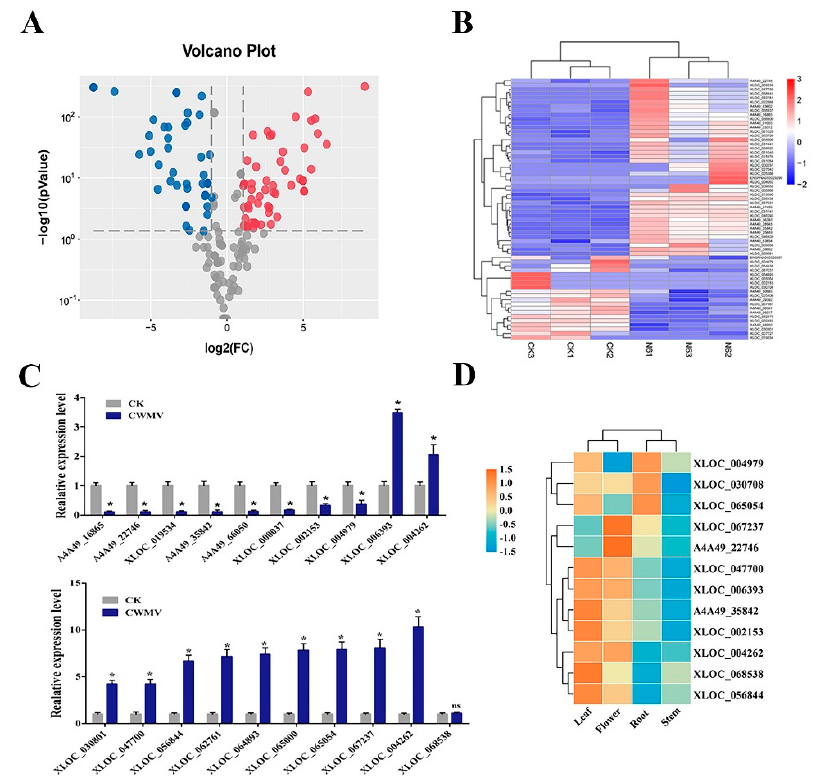
Figure 3. Identified differentially expressed lncRNA responses to Chinese wheat mosaic virus in Nicotiana benthamiana and verification of the expression level of differentially expressed lncRNAs (DElncRNAs) in different tissues by qRT ‐ PCR. ( A ) Volcano plots were created to distinguish DElncRNAs, Vertical lines indicate 2 ‐ fold up ‐ or down ‐ regulation, and horizontal lines represents p = 0.05. Red and blue dots represent up ‐ and down ‐ regulated lncRNAs, respectively. ( B ) Heatmap was constructed based on expression profile data of DElncRNAs between CK and CWMV infection samples (log 2 |fold ‐ change| >2 and false discovery rate <0.05), blue and red represent down ‐ and upregulated lncRNAs in different samples, respectively; ( C ) partial DElncRNAs were verified by qRT ‐ PCR. ( D ) Expression levels of partial DElncRNAs in different tissues, including root, stem, leaf, and flower, were analyzed by qRT ‐ PCR. Heatmaps were constructed based on the qRT ‐ PCR results, and red and blue colors represent higher and lower expression of lncRNAs in different tissues.